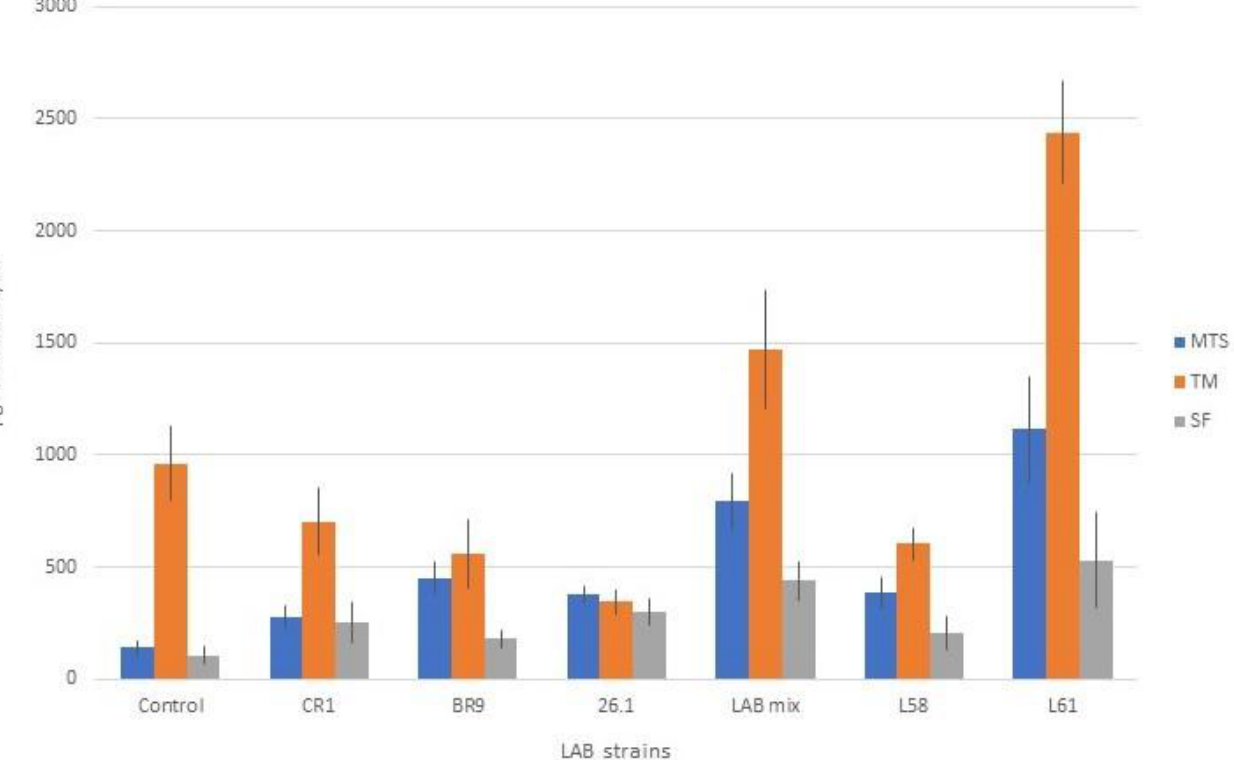
Figure 7. Acetic acid content in juice samples fermented with lactic acid bacteria.